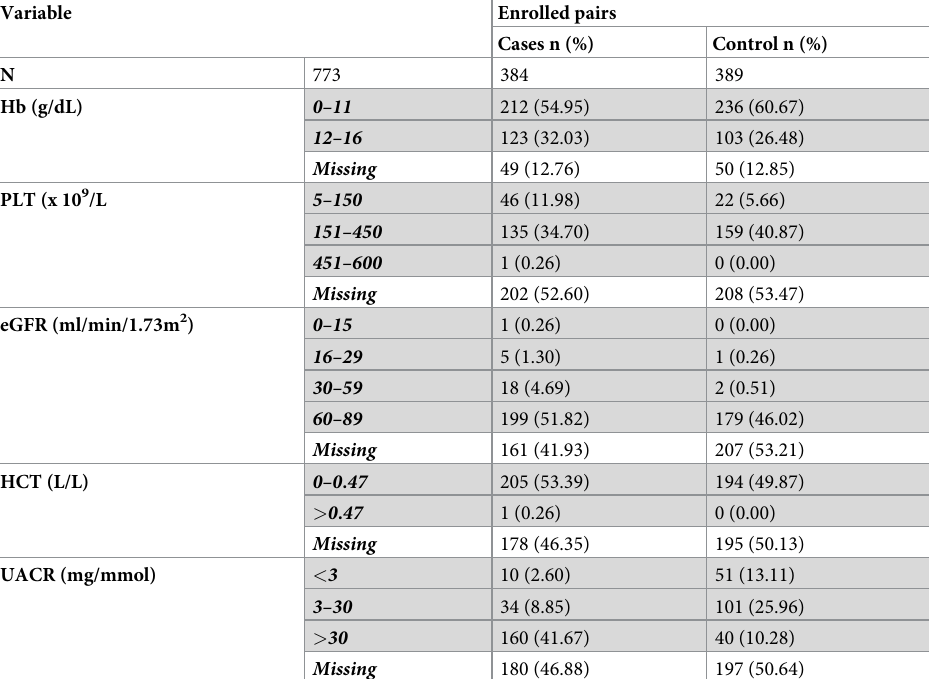
Table 4. Clinical parameters and hematological indicators of